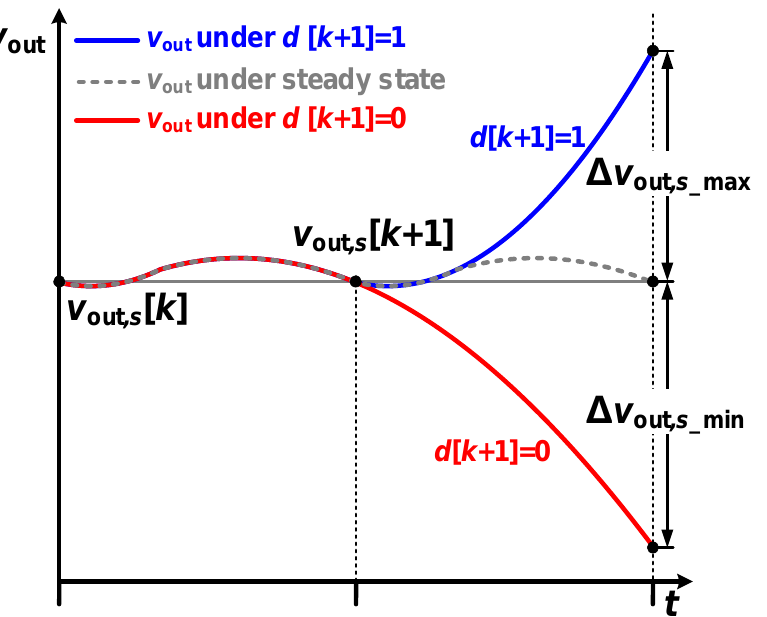
Figure 9. Practical DPVP controller with integral compensation and eliminated DPWM saturation.